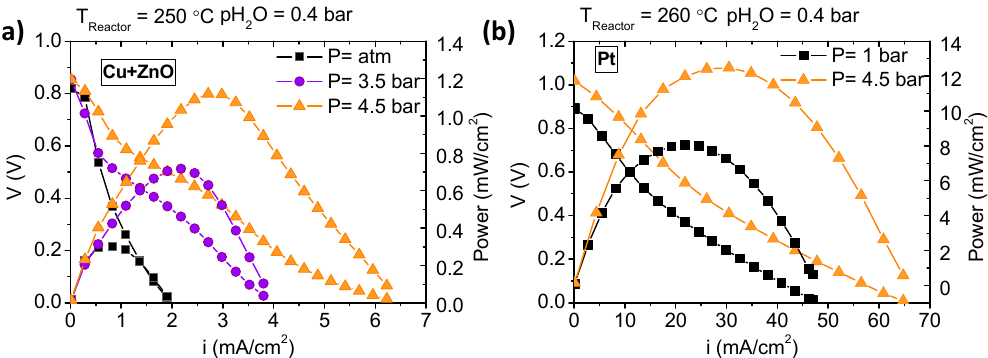
Figure 7. i - V curves of the Cu-ZnO on GDL/CsH 2 PO 4 /Cu-ZnO on GDL cell at 250 °C ( a ) and Pt on GDL/CsH 2 PO 4 /Pt on GDL cell at 260 °C ( b ) in a fuel cell mode for different total system pressure. Gases: Wet air (cathode) and wet H 2 (anode).